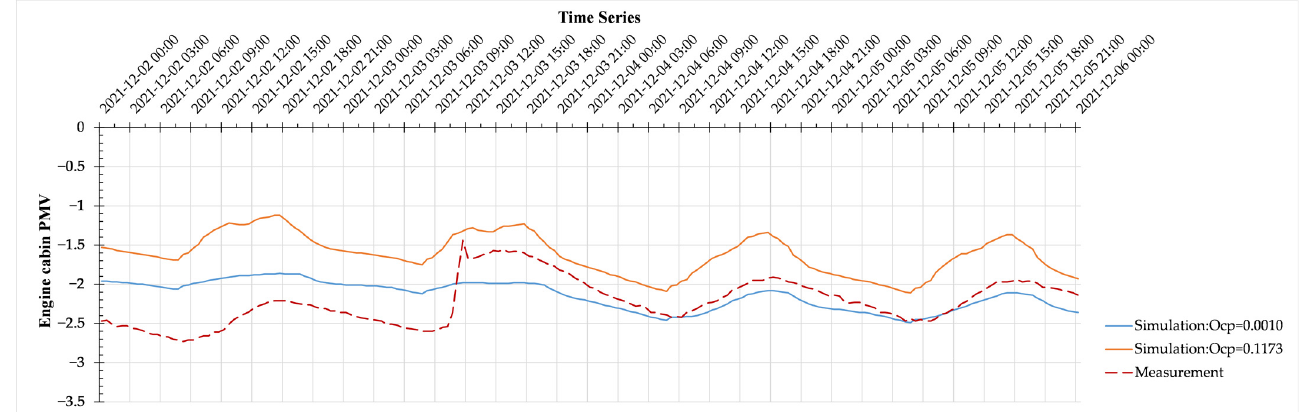
Figure B5. Engine cabin: predicted mean vote between 2 and 5 December 2021.